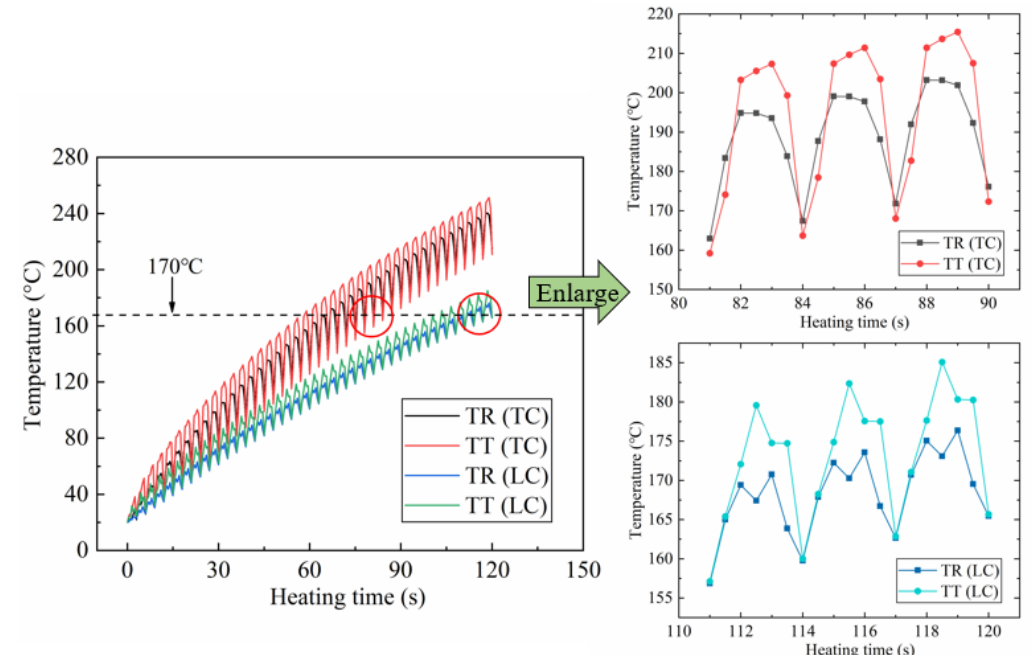
Figure 9. Temperature rise process under two coil